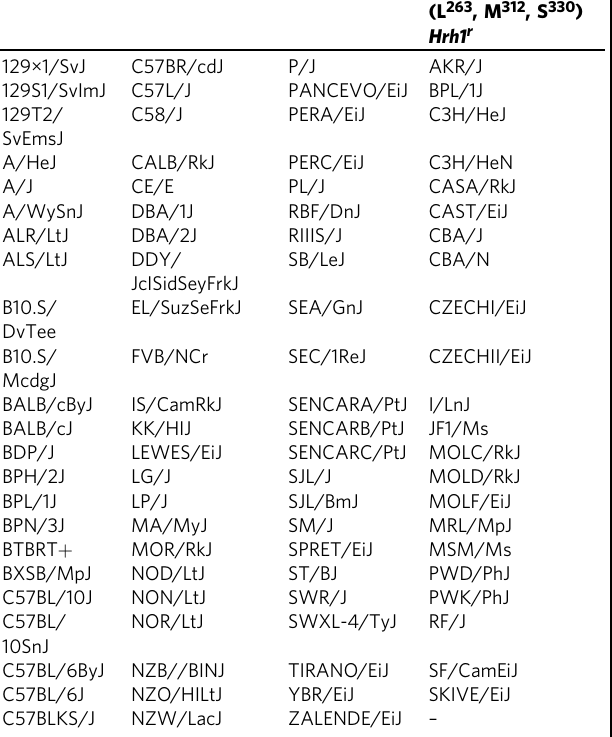
Table 1 Distribution of Hrh1 s and Hrh1 r alleles in laboratory and wild-derived inbred mouse